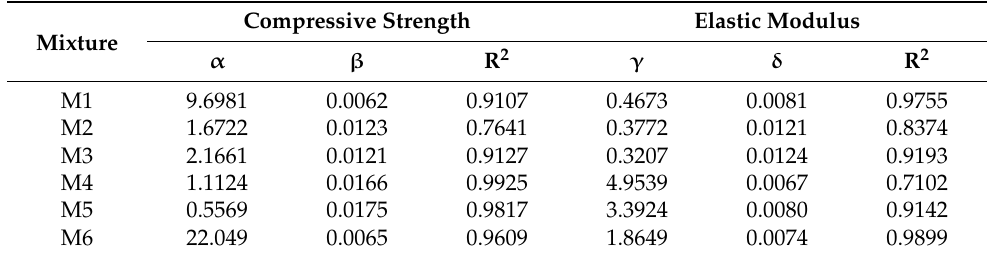
Table 6. Parameters of relationships between mechanical properties and shear wave velocity of CLSM.